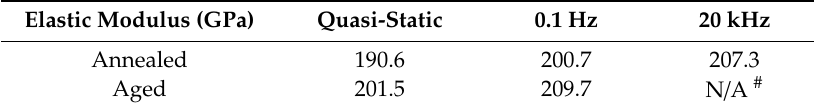
Table 5. Dynamic modulus under di ff erent loading frequencies.